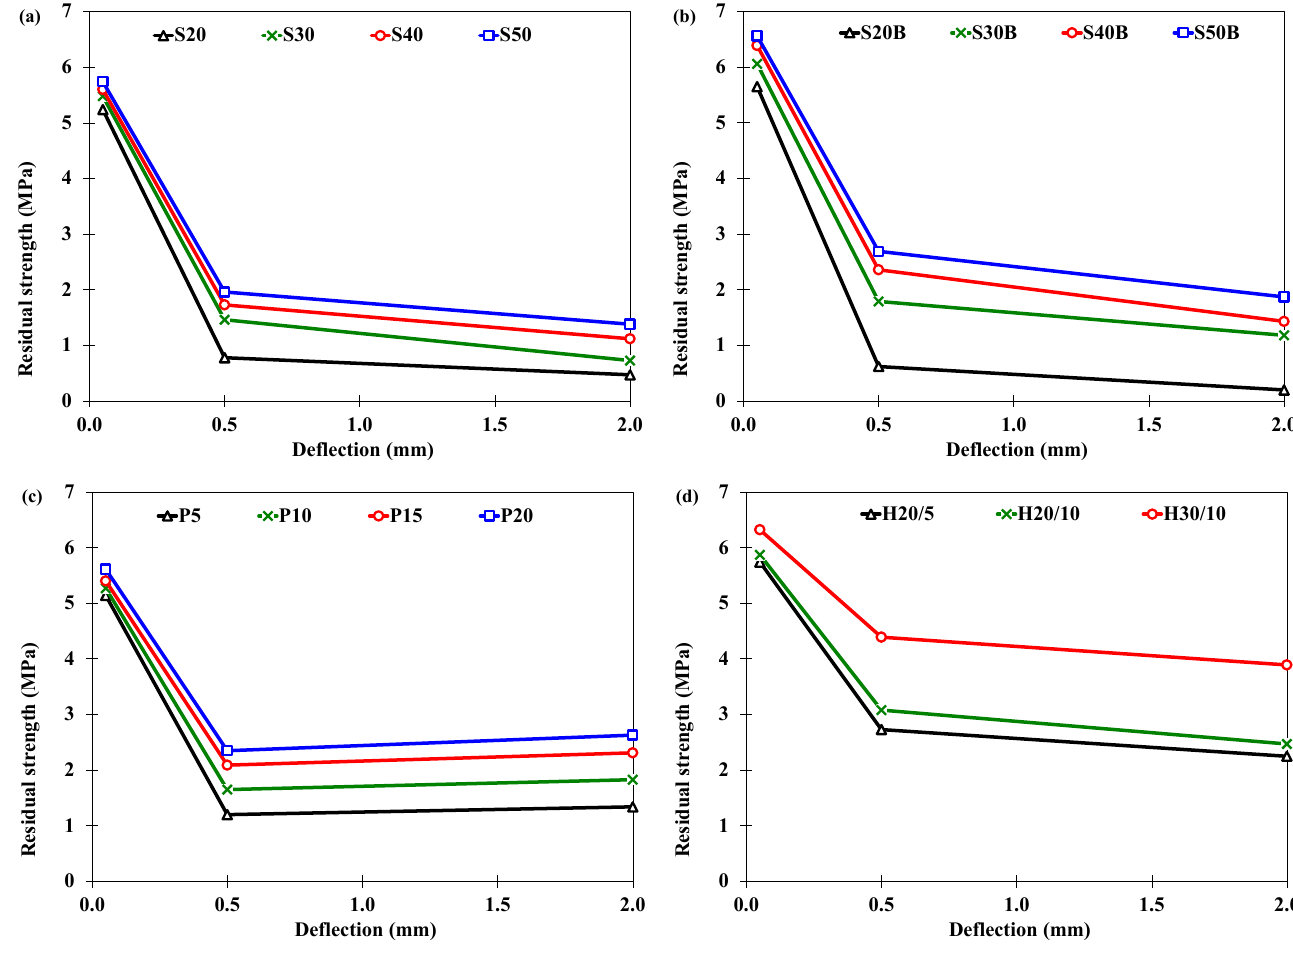
Figure 8. Residual strengths at deflections of L/600 (0.5 mm) and at L/150 (2.0 mm) for specimens incorporating ( a ) straight steel fibers, ( b ) bundled steel fibers, ( c ) PP fibers, ( d ) hybrid fibers (bundled steel fibers and PP fibers).